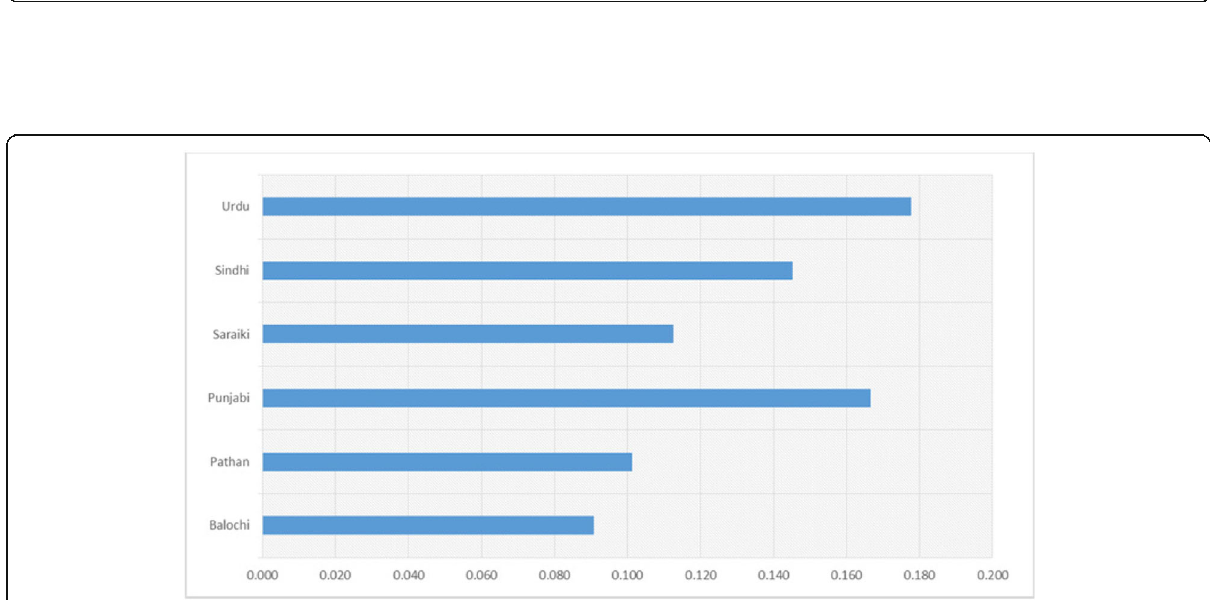
Fig. 2 Mutation Frequencies in the Most Prevalent Ethnic Groups In Our Cohort. Top: Locally predominant mutations; Bottom: Less abundant mutations; none of these were observed in Balochi patients (not shown)